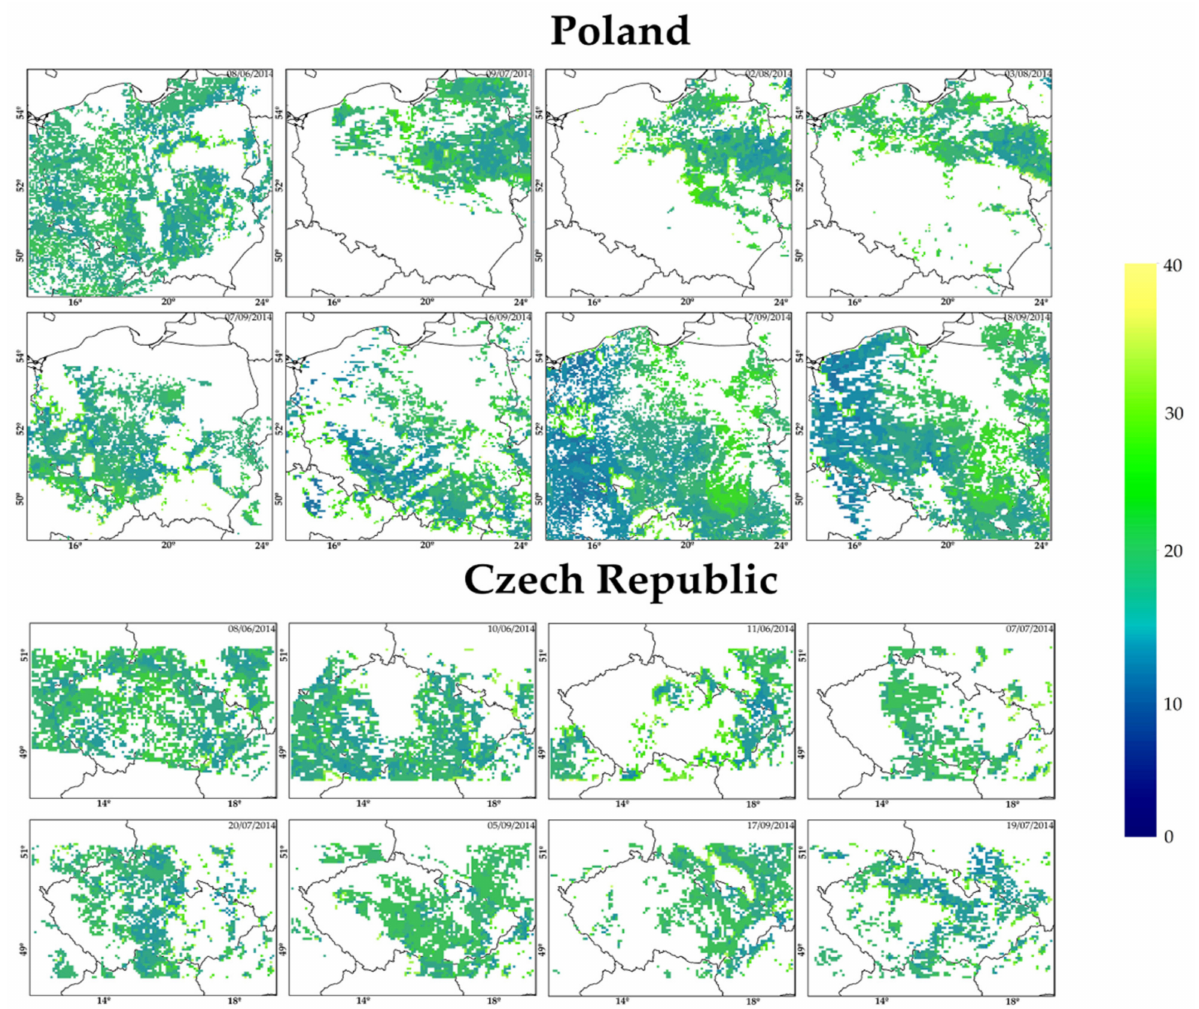
Figure 8. SEVIRI AOD uncertainty (UNC in %) specific for the Poland (upper) and Czech Republic (lower)